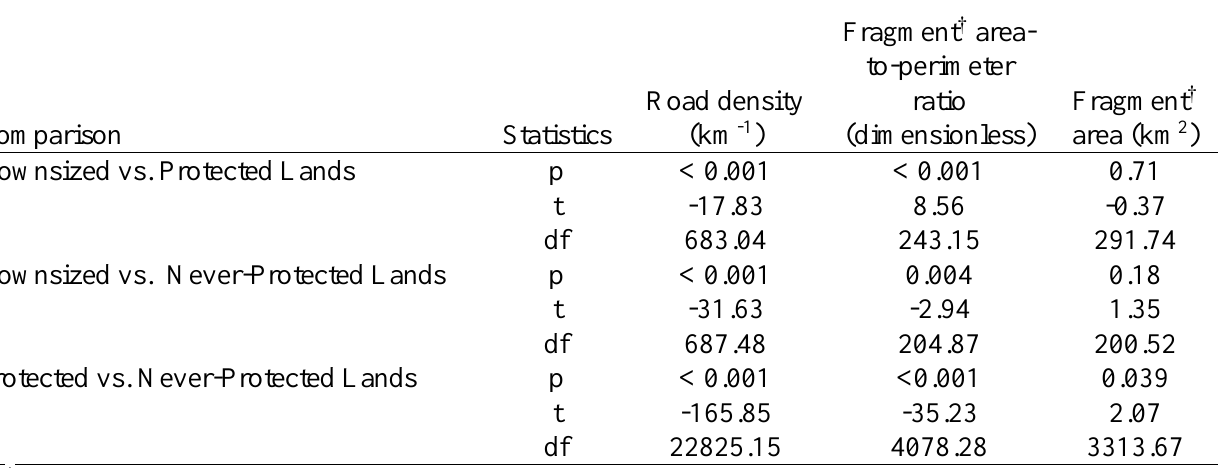
Table A1.15: Habitat fragmentation at the Ecoregional scale for all land cover types –results of post-hoc Welch’s t-tests from Table